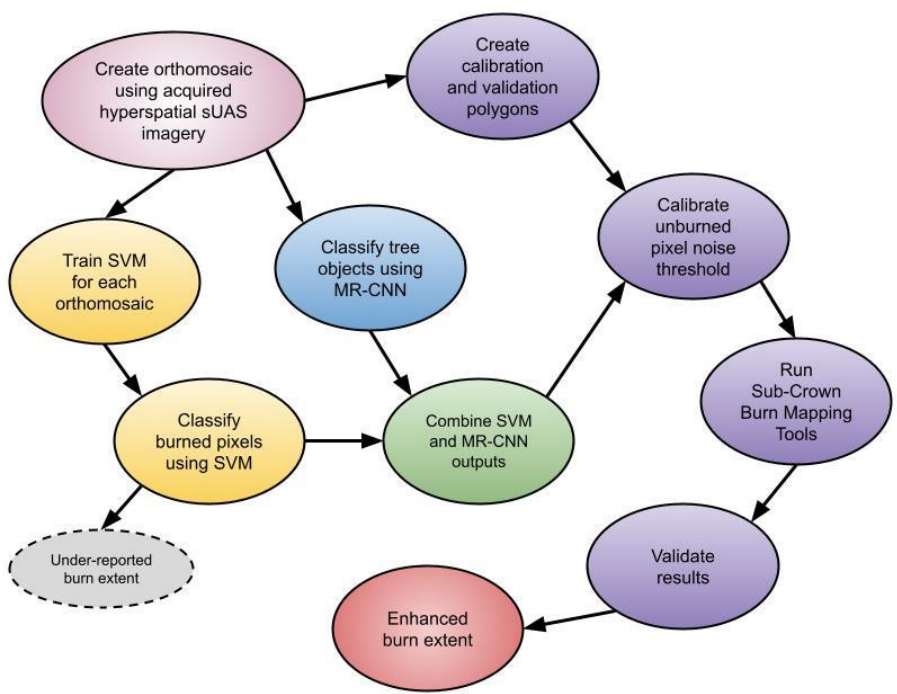
Figure 5. A flowchart summarizing the workflow to create an enhanced burn extent for a burned area. Each bubble is a significant step in the process. The colors have little significance, only showing very general correlations between bubbles. The dashed bubble is not part of the workflow; it shows what step produced the under-reported burn extent used previously.